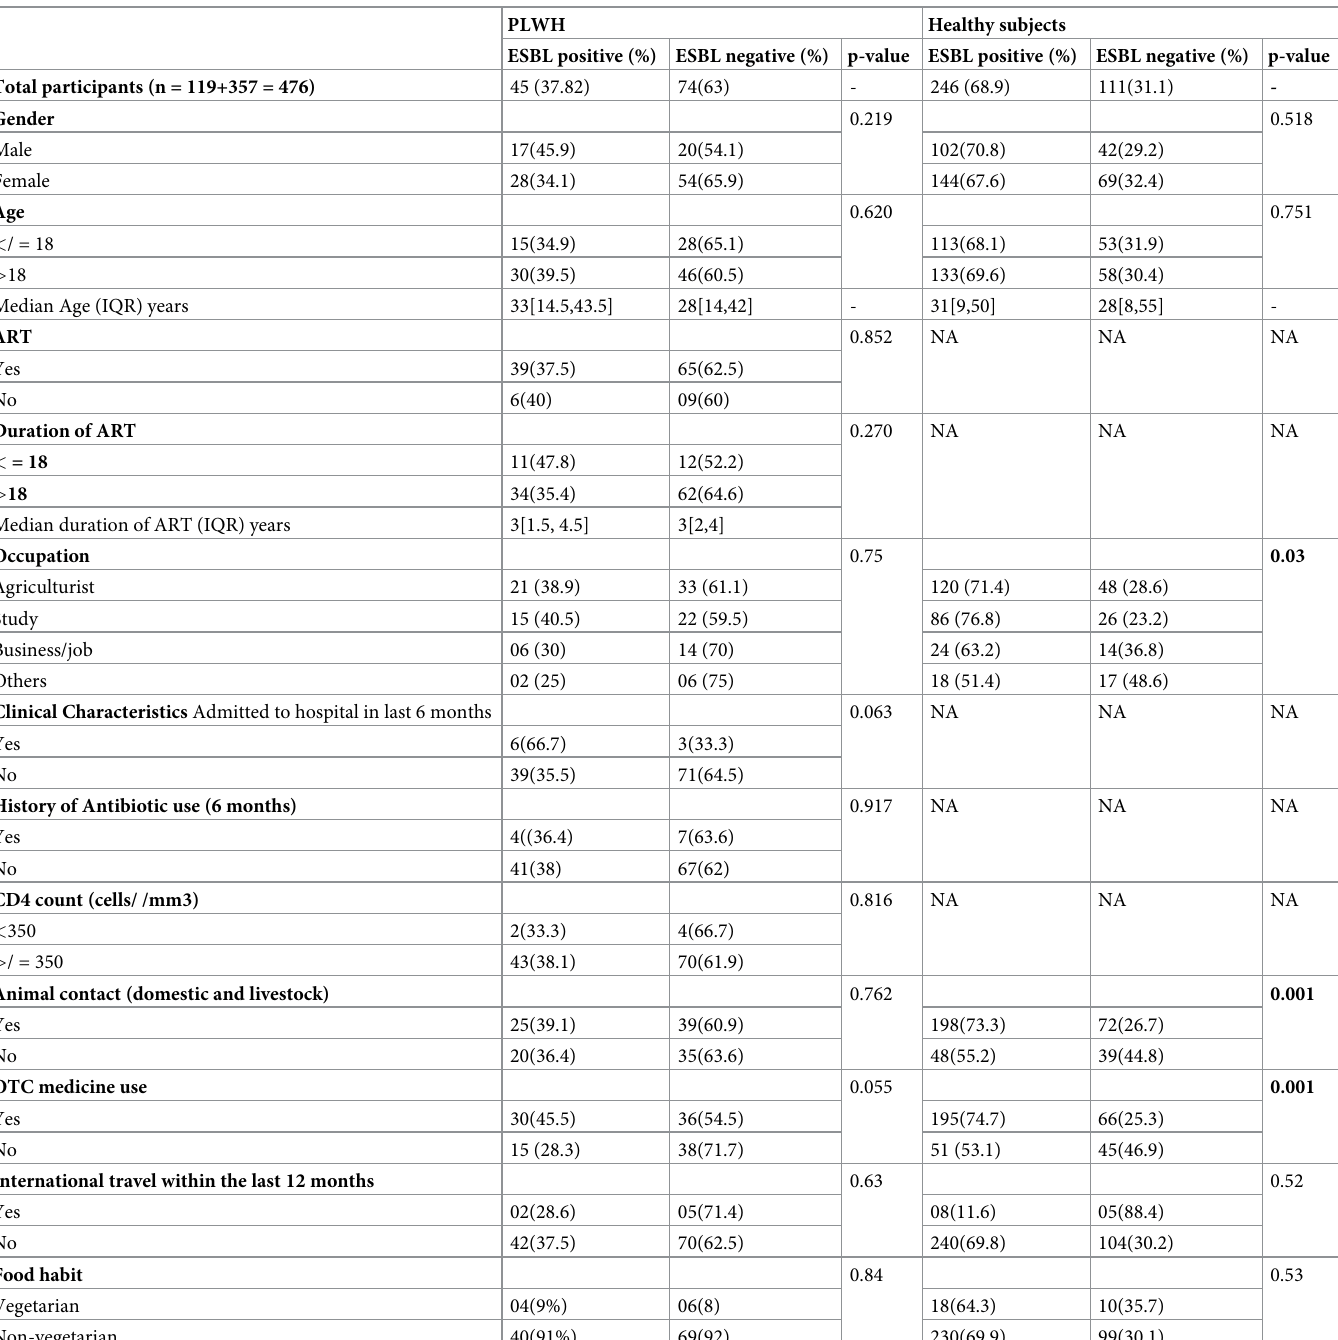
Table 1. Demographic and clinical characteristics in PLWH and healthy